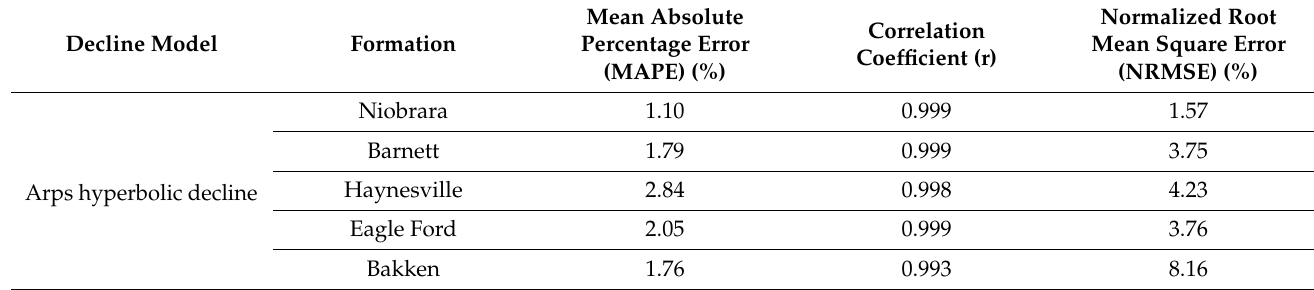
Table 3. Error analysis results for production history matching using entire production history with the Arps hyperbolic decline model.